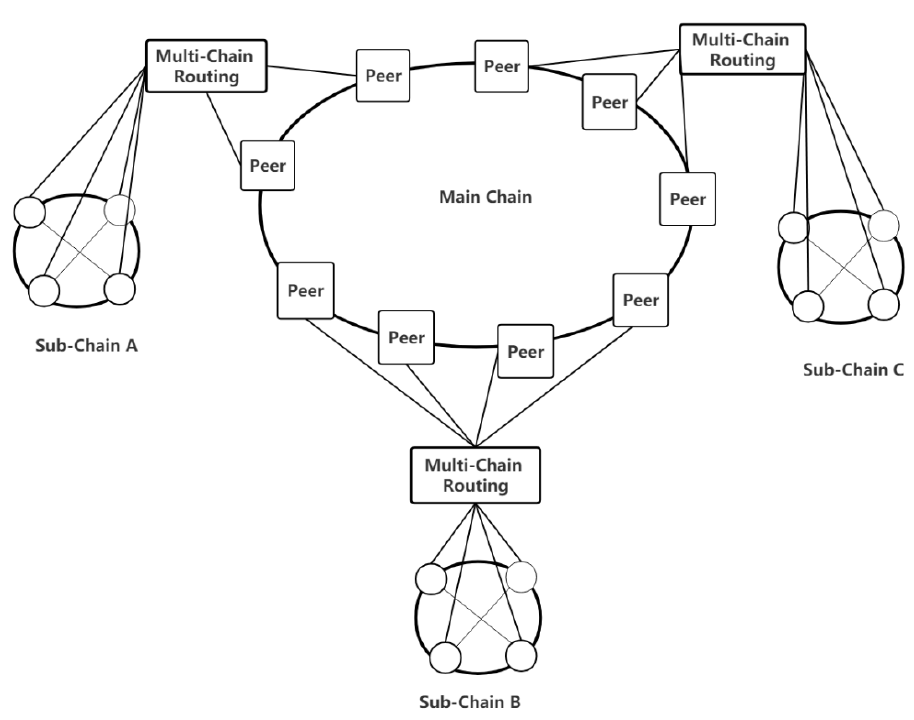
Figure 1. Overview of the multi-chain architecture.